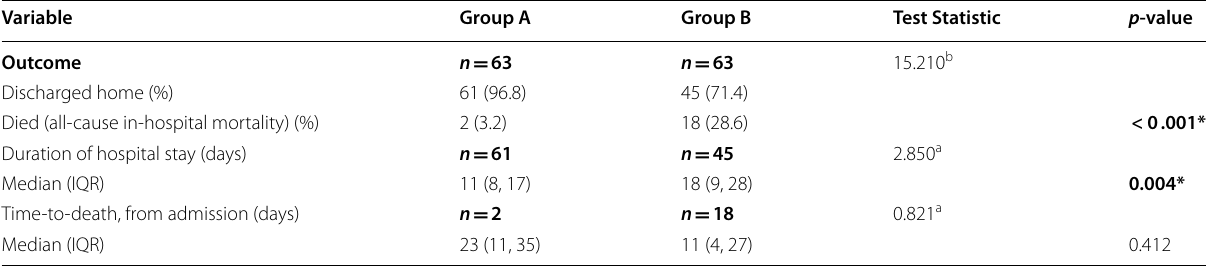
Note: a Wilcoxon rank-sum test (Z) b Fisher’s exact test * Statistically significant p -value